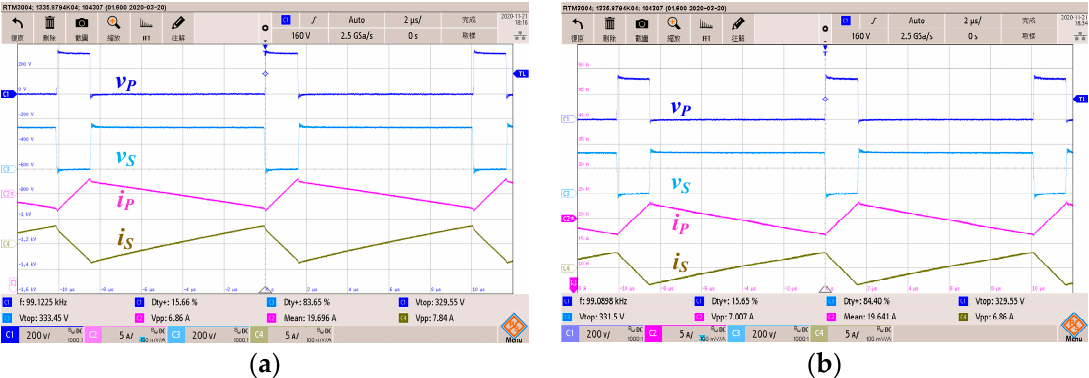
Figure 28. Measured waveforms of the switching node voltage and inductor current: ( a ) conventional dead time; ( b ) low output ripple dead time modulation. [scale v P (Ch1): 200 V/div; i P (Ch2): 5 A/div; v S (Ch3): 200V/div; i S (Ch4): 5A/div; time: 2 µ s/div].